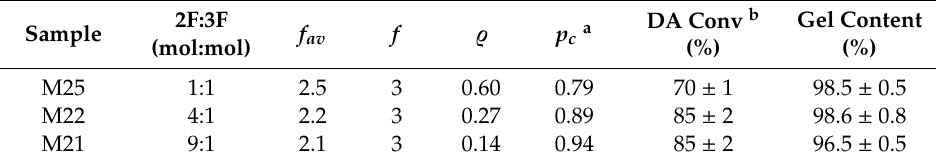
Table 1. Average furan functionality of 2F / 3F blends and properties of the DA networks obtained after crosslinking with BM, namely predicted critical extent of reaction ( p c ), Diels–Alder conversion, and insoluble fraction in